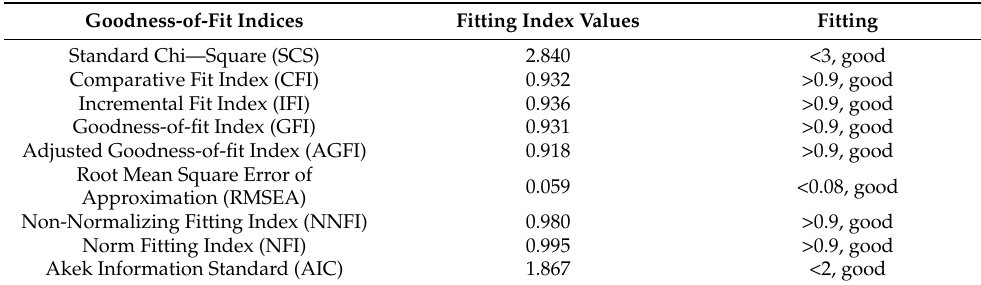
Table 6. Structural equation modeling fitting.